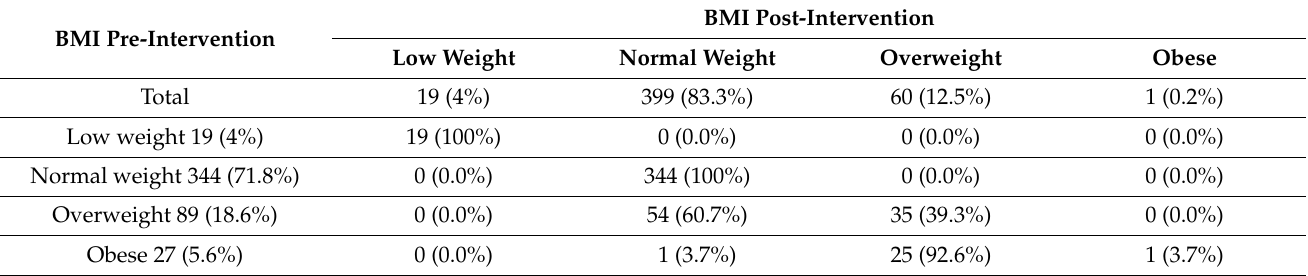
Table 2. Comparative analysis of BMI values pre- and post-intervention. Number and percentage